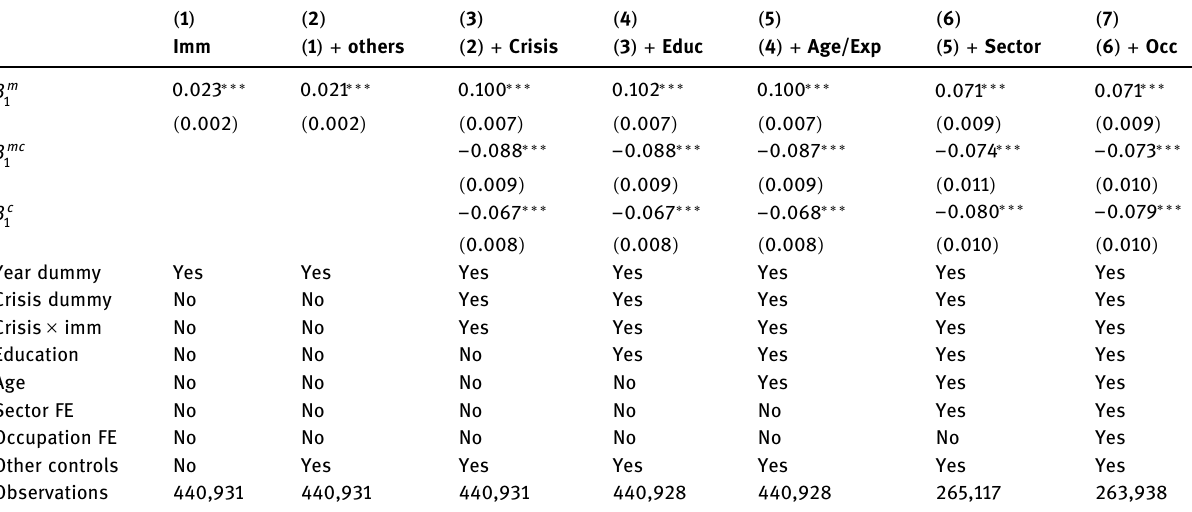
Table 2: Estimation results: UE